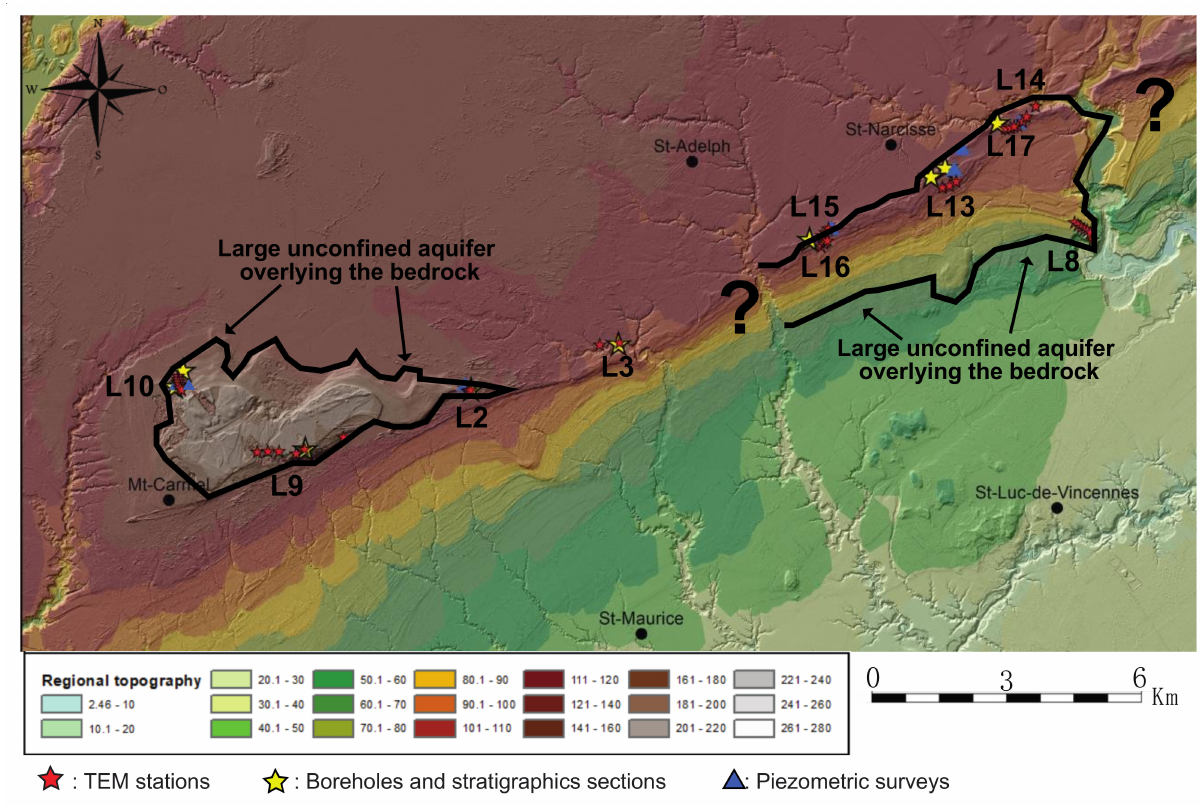
Figure 13. Regional topography of the study area and location of TEM stations, boreholes, stratigraphic cross-sections, and piezometric surveys acquired on the Saint-Narcisse moraine, Quebec. The black lines delimit two large unconfined regional aquifers west of Notre-Dame-du-Mont-Carmel and southeast of